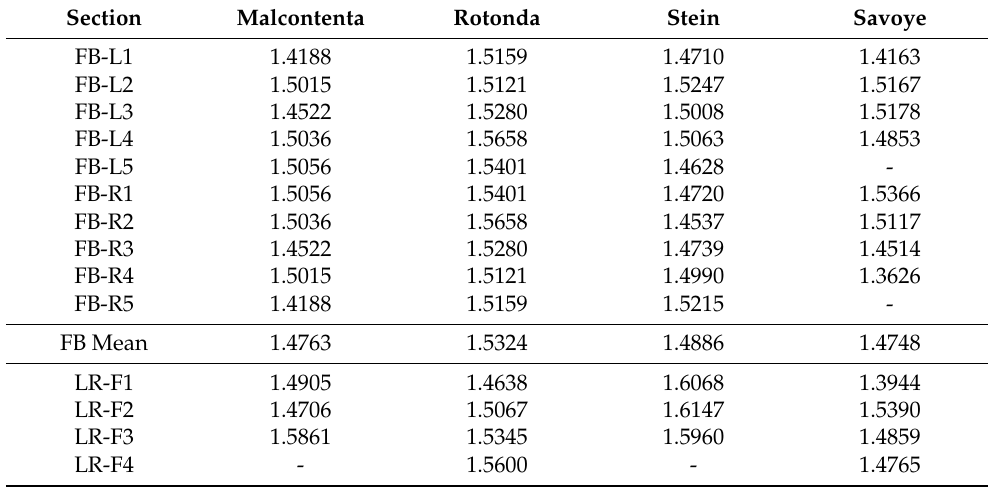
Table 3. D values of